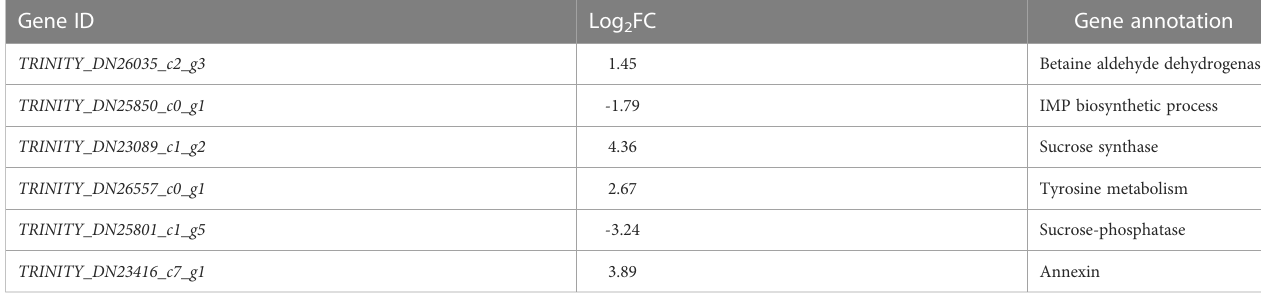
TABLE 2 Differentially expressed genes related to osmoregulation.